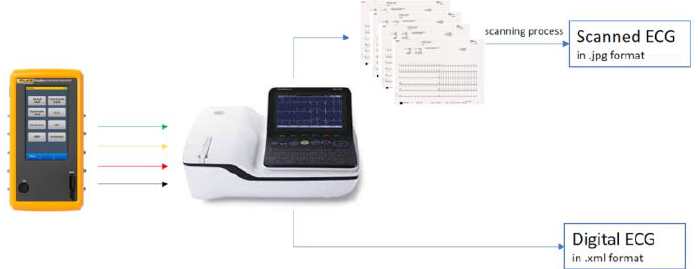
Figure 1. Data acquisition system. The scanning process is done by the Kyocera TASKalfa 5053ci scanner.